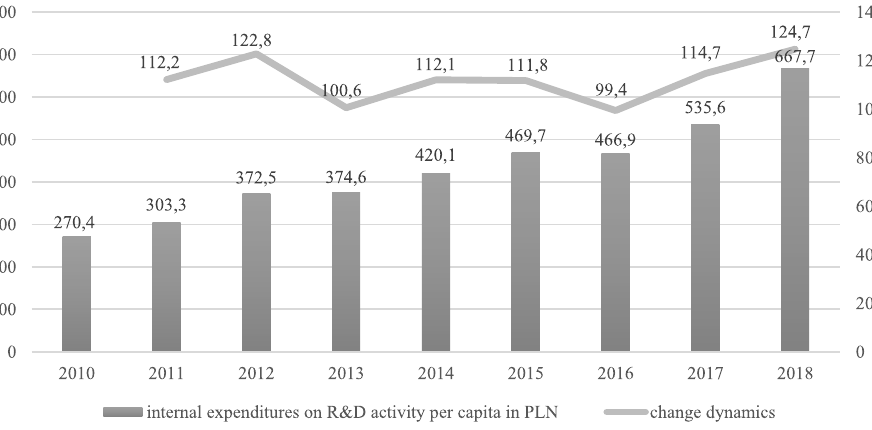
Figure 2. Gross domestic expenditures on R&D per capita in PLN and their dynamics (previous year = 100) in